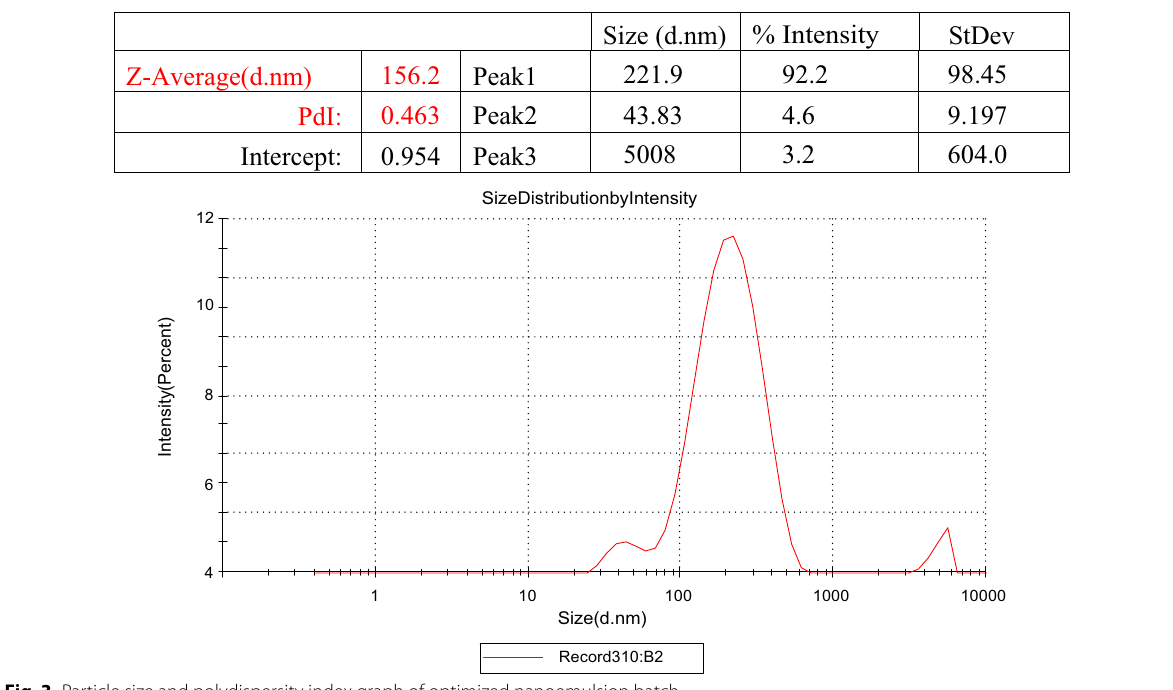
Fig. 3 Particle size and polydispersity index graph of optimized nanoemulsion batch